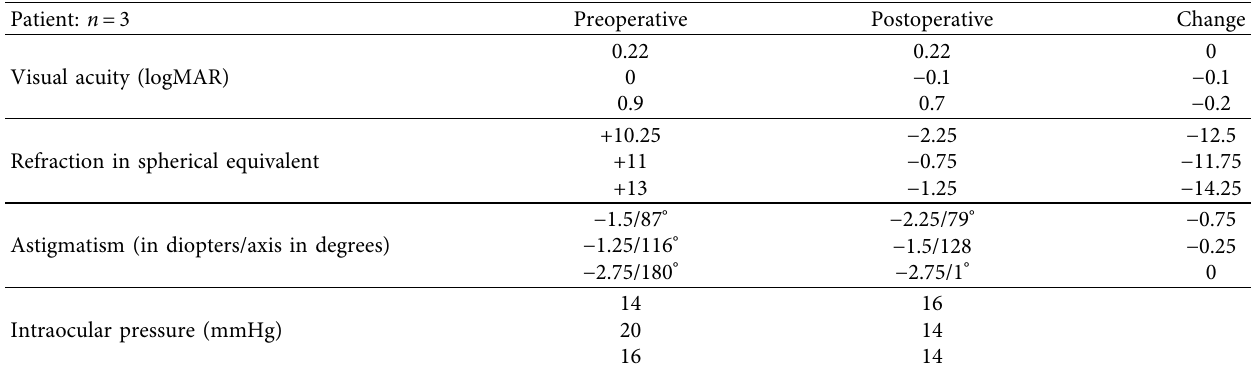
Table 1: Evolution of visual acuity, spherical equivalent, astigmatism, and intraocular pressure in the patient population.